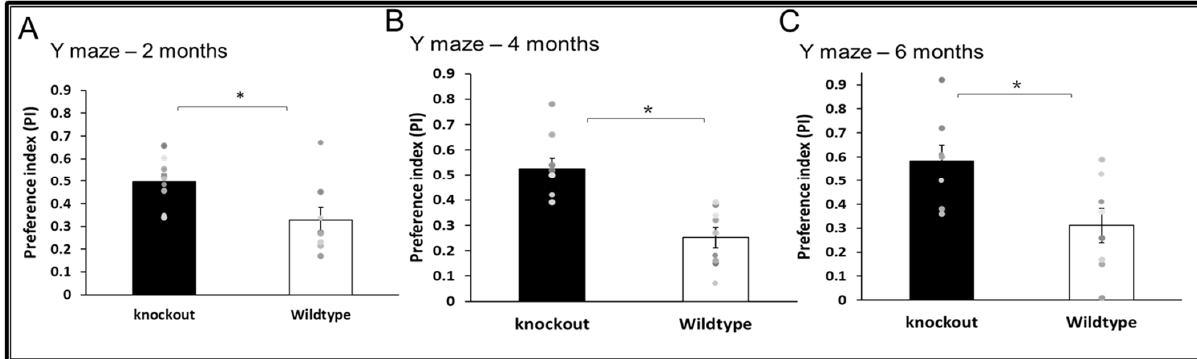
Figure 3. The effect of CD24 knockout on short-term memory. Abolition of CD24 increased short term memory in the Y-maze at 2 months ( A ), 4 months ( B ) and 6 months ( C ). n = 8 mice per group. * indicated p <